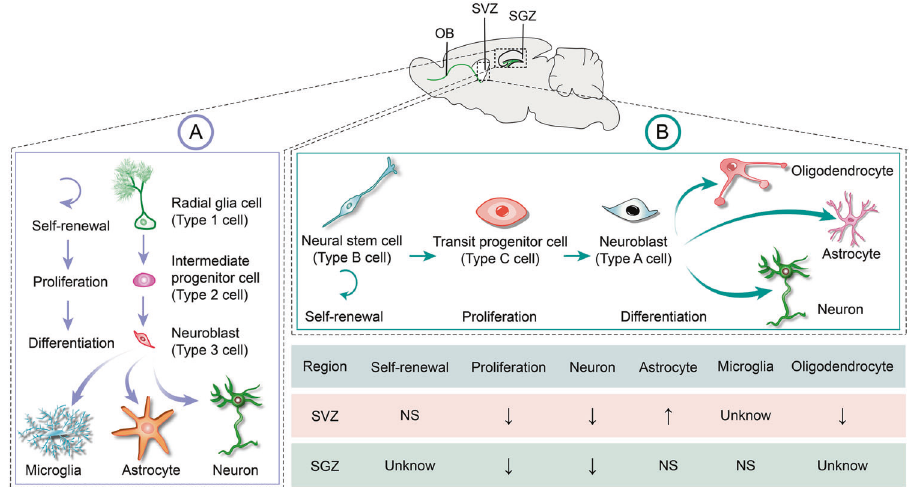
Fig. 6 Schematic diagram of the in fl uence of SHANK3 de fi ciency in determining the fate of NSCs. A The in fl uence of SHANK3 on NSC proliferation and differentiation in SGZ. B The in fl uence of SHANK3 on NSC self-renewal, proliferation, and differentiation in